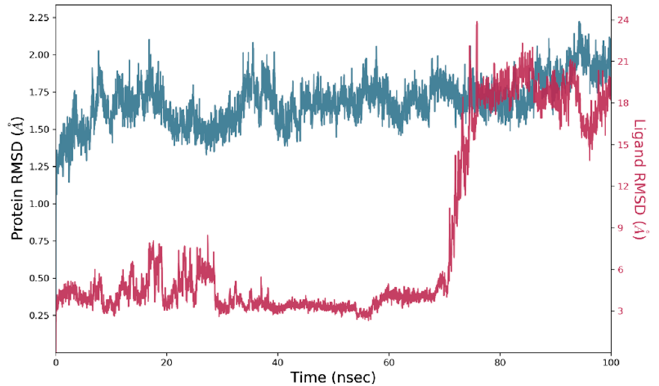
Figure 8. RMSD plot obtained for 4b-helicase (6MH3) complex: protein C α and compound 4b RMSD shown in blue and red color, respectively.